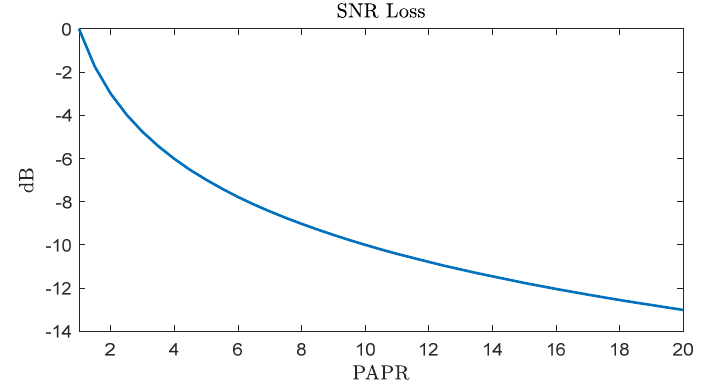
Figure 4. SNR loss versus